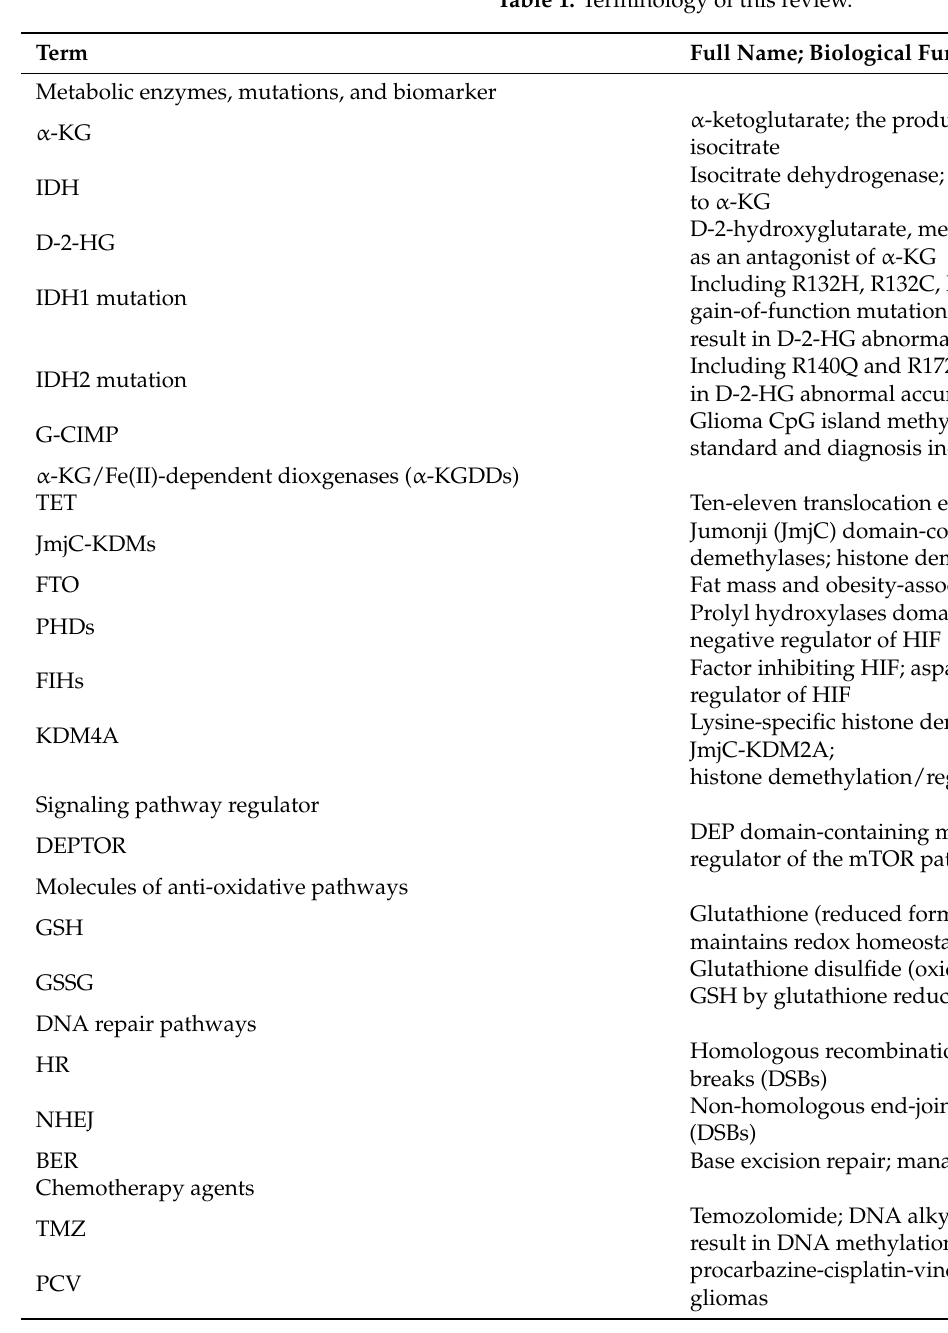
Table 1. Terminology of this